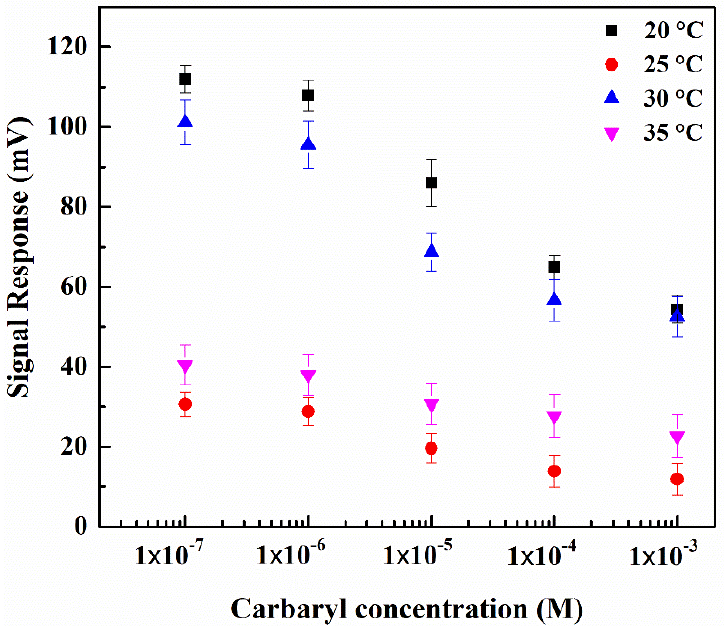
Figure 10. The ISFET signal response under variable concentrations of PBS-diluted carbaryl, given the solution temperatures of 20, 25, 30, and 35 °C.